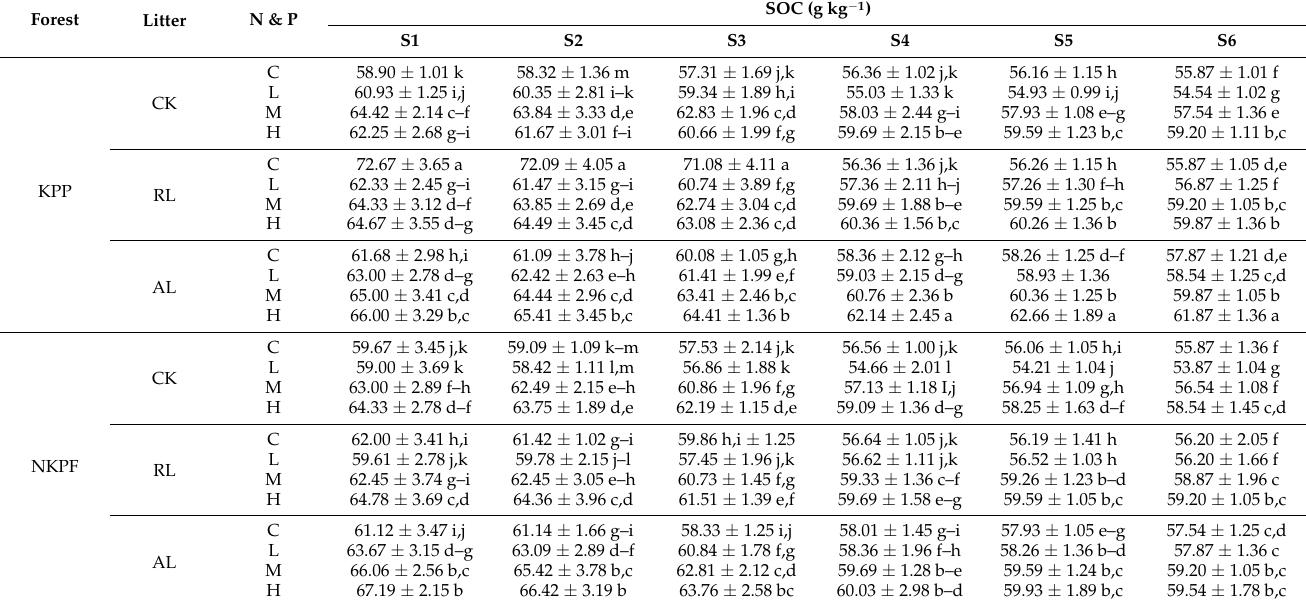
Table 2. Changes in soil organic matter by N and P inputs along with litter treatments across six